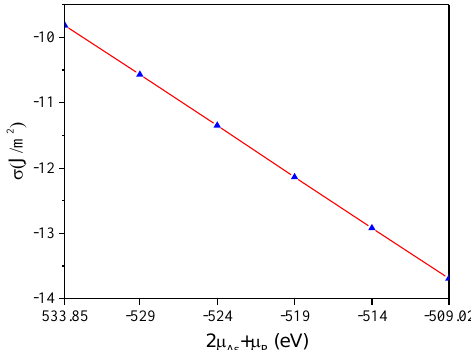
Figure 2. In 0.87 Ga 0.13 As 0.25 P 0.75 (001)β 2 (2×4) surface energy.